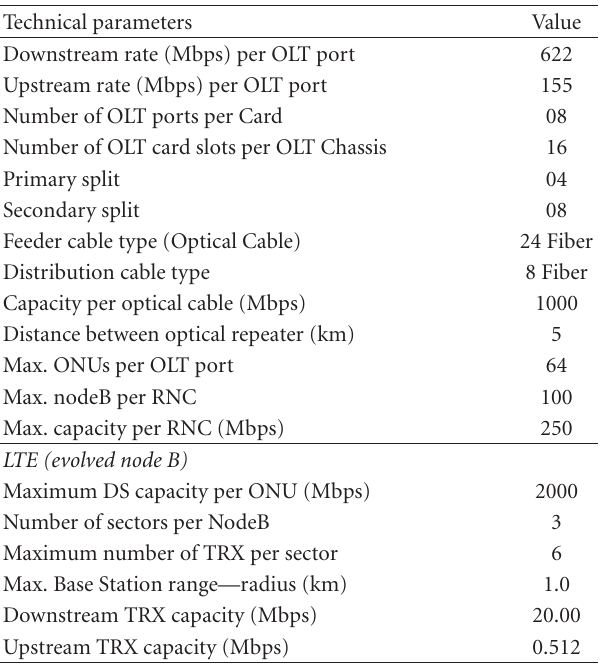
Table 10: Technical